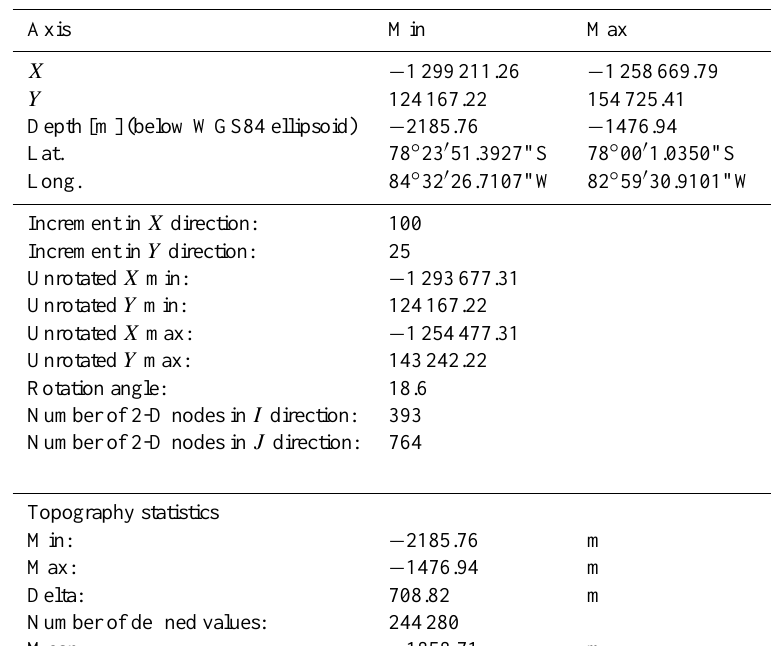
Table 1. Projection: Antarctic polar stereographic, WGS84 ellipsoid, Prime Meridian 0.0, standard parallel 71 ◦